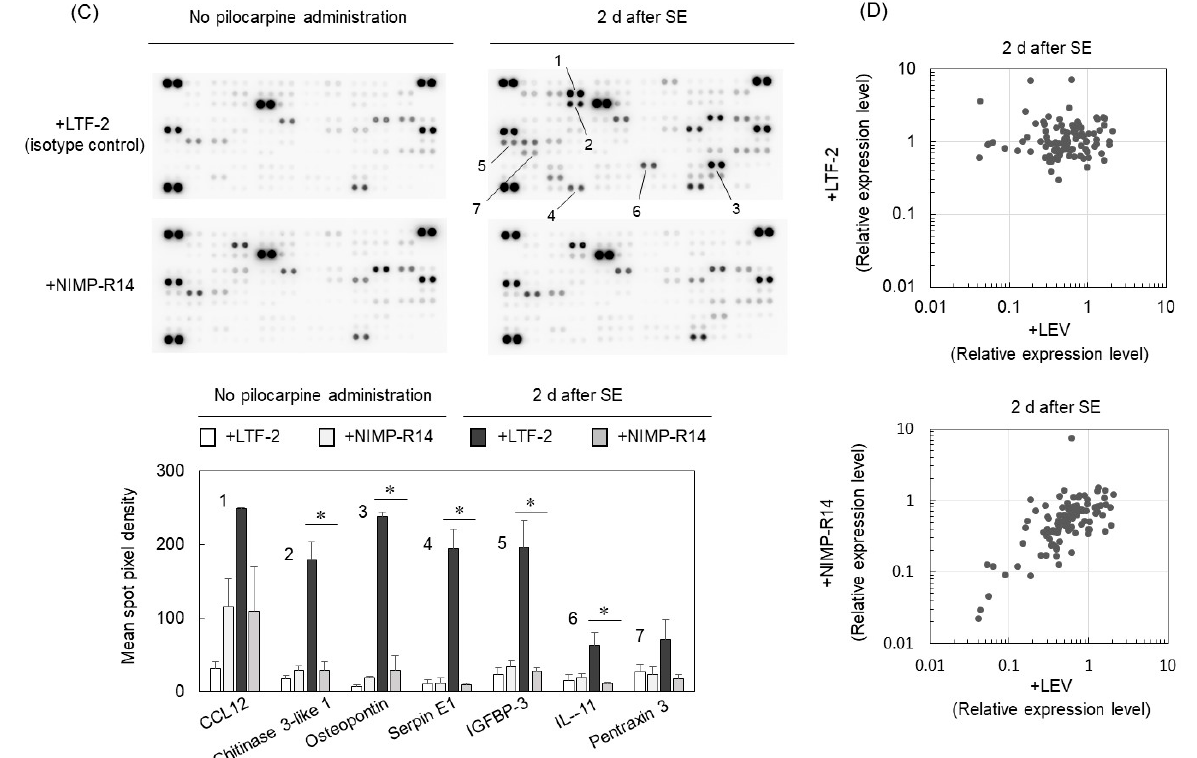
Figure 4. The effects of NIMP-R14 administration on pilocarpine-induced SE. ( A ) Mice were admin- istered an intraperitoneal injection of NIMP-R14 or LTF-2 which is the rat IgG2b isotype control. The Ly6G + Ly6C + cell subset in the peripheral blood was evaluated 1 d and 3 d after antibody injec- tion by flow cytometry. The results are representative of 3 independent experiments. ( B ) Mice were administered an intraperitoneal injection of NIMP-R14 or LTF-2 one day prior to pilocarpine ad- ministration. At 2 d after SE, mice were killed and immune cell fractions were prepared from the hippocampi for flow cytometry analysis. Brain-infiltrating leukocytes were identified the based on expression of CD11b and CD45. Neutrophils were then identified based on the expression of Ly6G and Ly6C. The results are representative of 4 independent experiments. ( C ) Mice were administered an intraperitoneal injection of NIMP-R14 or LTF-2 one day prior to pilocarpine administration. At 2 d after SE, the lysates of whole hippocampi were analyzed by a Proteome Profiler Mouse XL Cyto- kine Array kit. The nonpilocarpine-administration groups were killed 3 days after antibody injec- tion, and hippocampal lysates were prepared. The numbers shown in the right panel of LTF-2 cor- respond to the numbers in the bar graph. Pixel intensities of spots were measured using image anal- ysis software. Bar graphs show the representative altered proteins. n = 3 mice per group. Data are means ± SEMs. * p < 0.05, unpaired t test. ( D ) Cytokine expression patterns were compared between LEV-treated and LTF-2-treated mice (top panel) and between LEV-treated and NIMP-R14-treated mice (bottom panel) with cytokine arrays. The relative expression in mice 2 d after SE was normal- ized to the mean of LEV-treated or antibody-treated mice from mice treated with pilocarpine only.